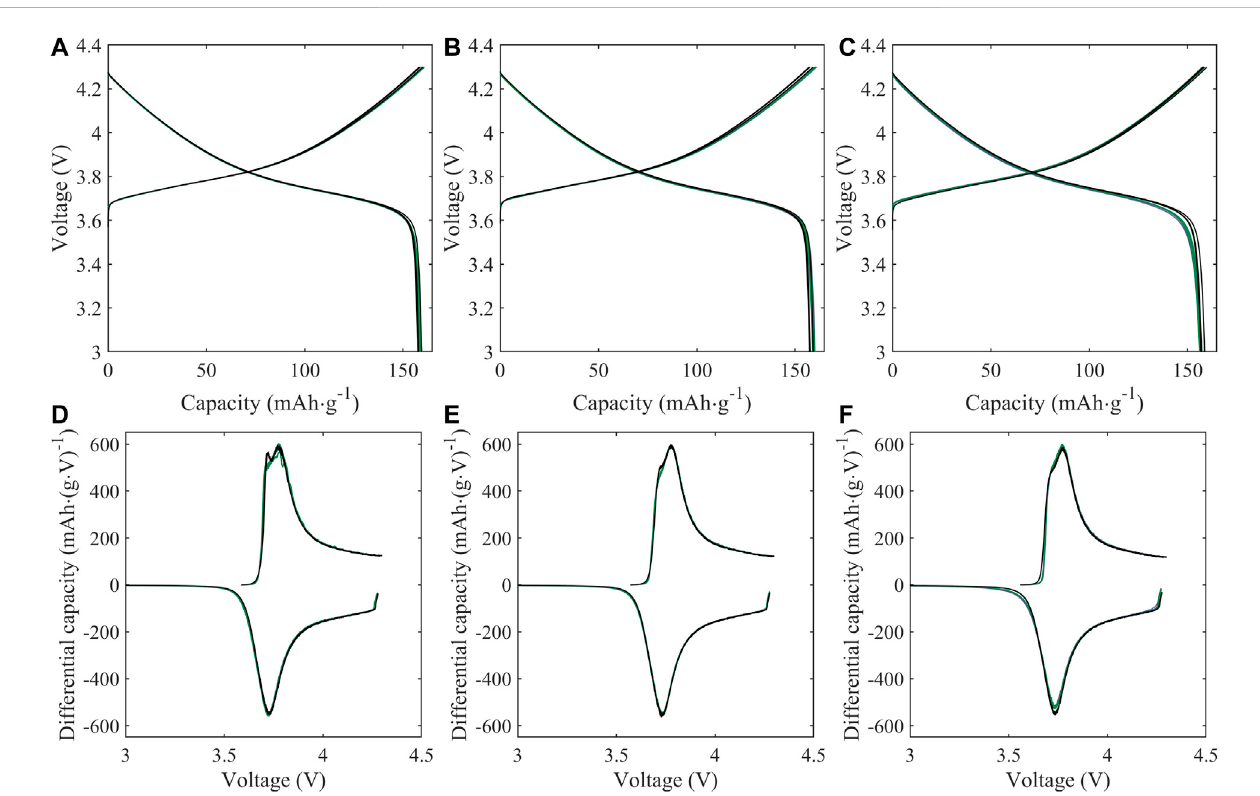
FIGURE 4 Voltagepro fi les (A – C) anddifferentialcapacity(dQ/dV; (D – F) )ofhalfcellspreparedwithNMC-111:pristine(black)orfollowingtreatmentinKOH(green) or KOH + KCl (purple) matrix. Data is reported for the initial formation cycle (A,D) ; the fi nal formation cycle (B,E) ; and the 10th C/10 cycle following formation (C,F) . For plots (A – C) , cell replicates are shown as multiple curves of the same color; for plots (D – F) , one representative cell is shown for each condition. All treated NMC samples were subject to the same processing environment (i.e., sonication at 60 ° C for 2.5 h).